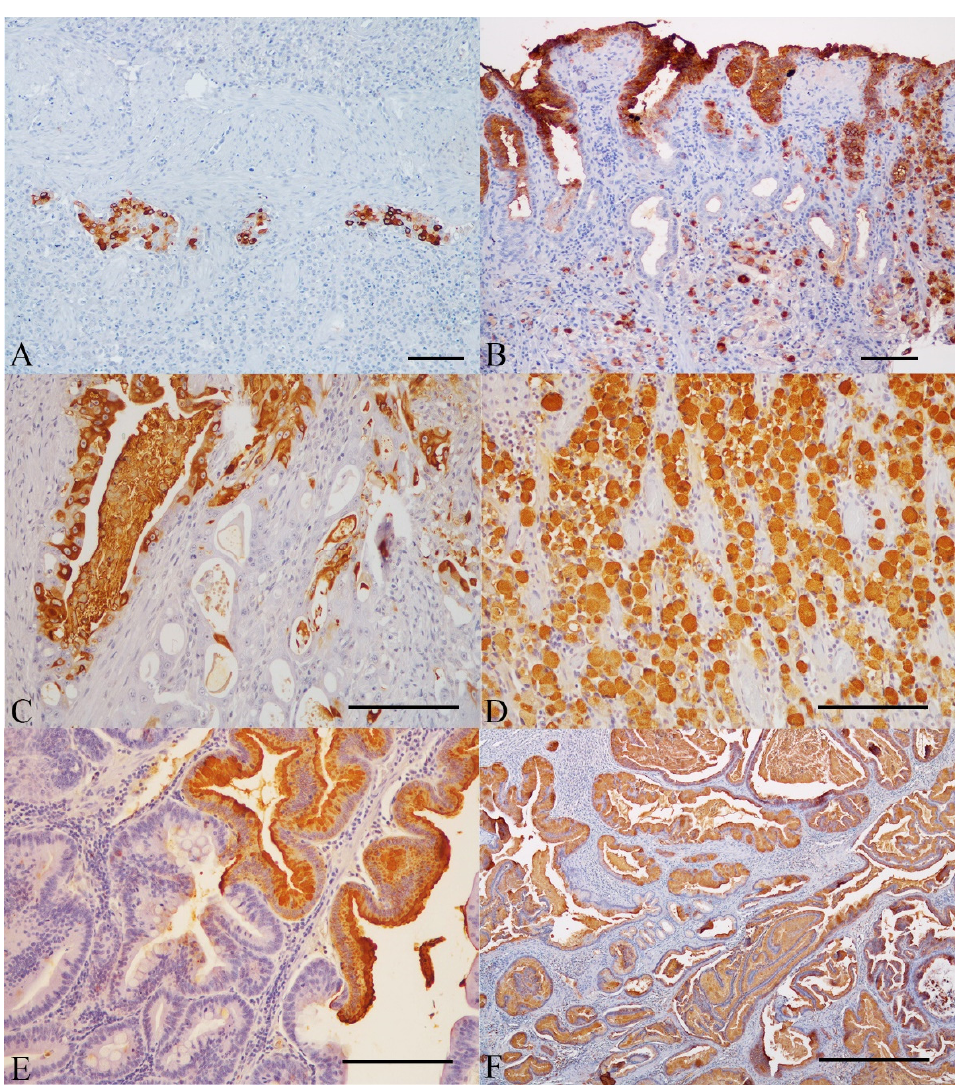
Figure 4. Gastric carcinomas. Immunohistochemistry for TFF1 counterstained with Mayer´s hematoxylin. ( A ) Absence of TFF1 expression (<5% of immunoreactive cells) in a poorly cohesive carcinoma (WHO) and diffuse type carcinoma (Lauren) and increased expression of TFF1 in neoplastic emboli (bar = 100 μ m). ( B ) Reduced expression of TFF1 (25–75% of immunoreactive cells) in a signet ring cell carcinoma (WHO) and diffuse type carcinoma (Lauren) (bar = 100 μ m). Note the intense TFF1 expression in adjacent superficial gastric mucosa. ( C and D ) Reduced expression of TFF1 (25–75% of immunoreactive cells) in a mixed carcinoma (WHO) and indeterminate type carcinoma (Lauren). Note reduced expression of TFF1 (25–75% of immunoreactive cells) in the intestinal (tubular) component while in diffuse component the expression was preserved (>75% of immunoreactive cells) (bar = 100 μ m). ( E ) No TFF1 expression was observed in the foci of IM in a papillary carcinoma (WHO) and intestinal type carcinoma (Lauren) (bar = 100 μ m). ( F ) Preserved expression of TFF1 (>75% of immunoreactive cells) in a tubular carcinoma (WHO) and intestinal type carcinoma (Lauren) (bar = 500 μ m).